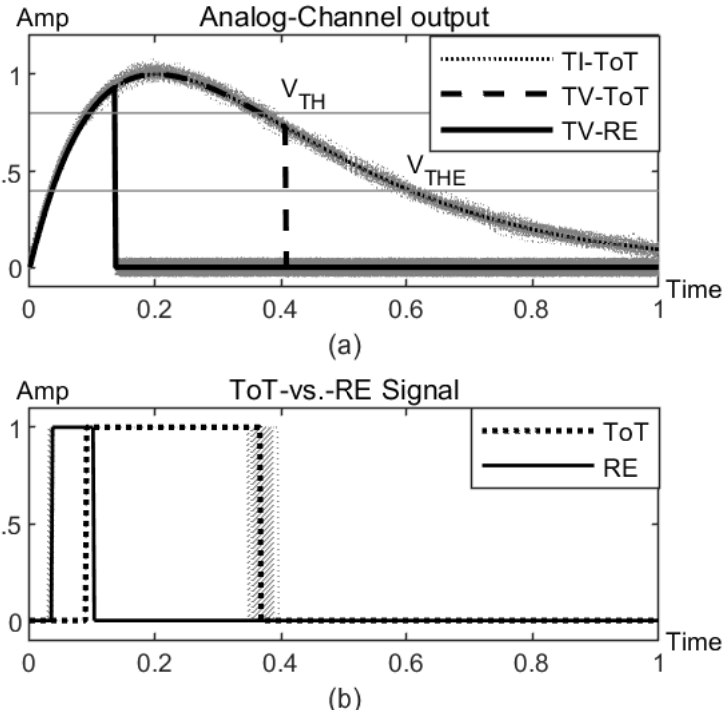
Figure 6. ( a ) Analog-channel time domain outputs for TI-ToT, TV-ToT and TV-RE techniques; ( b ) ex- tracted ToT and RE signals of the analog-channel